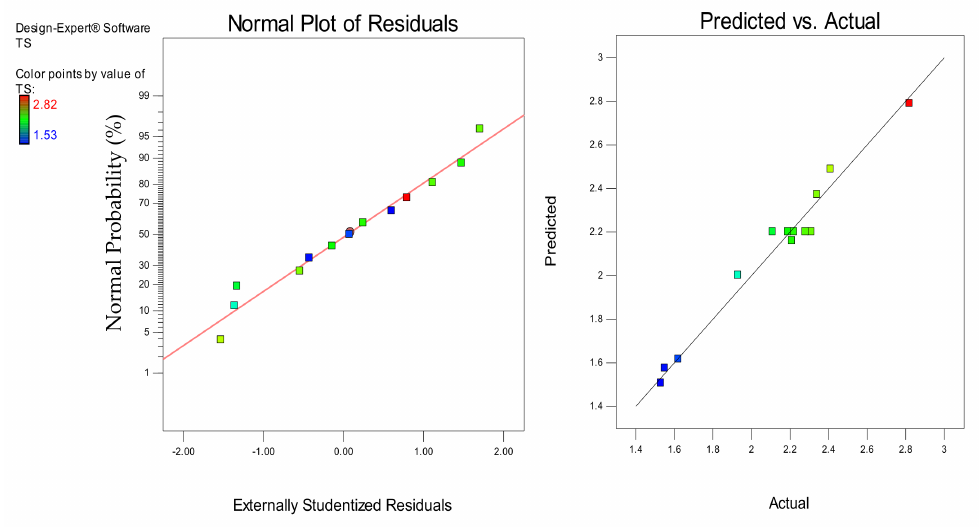
Figure 18. Normal plot of residuals and predicted vs. actual plots for the